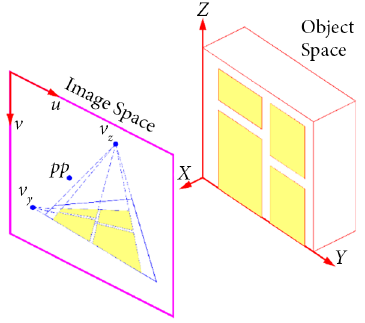
Figure 1. Object coordinate system vs. image coordinate system